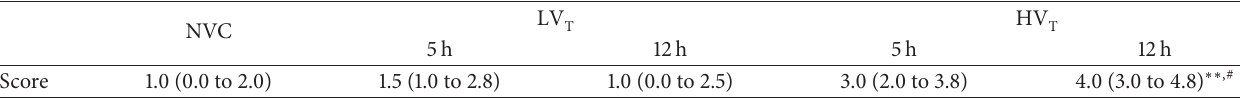
Figure 7: Histopathology. Lung sections were stained with hematoxylin eosin (H&E) to analyze lung histopathology (magnification 100x). Total histopathology score was determined by the sum of the score for 4 pathologic parameters: (a) edema, (b) hemorrhage, (c) interstitial cell infiltration, and (d) hyaline membranes. NVC = nonventilated controls; LV T , HV T = LV T /PEEP or HV T /ZEEP ventilator settings; 5h, 12h = 5 or 12 hours of ventilation. Table 2: Total histopathology